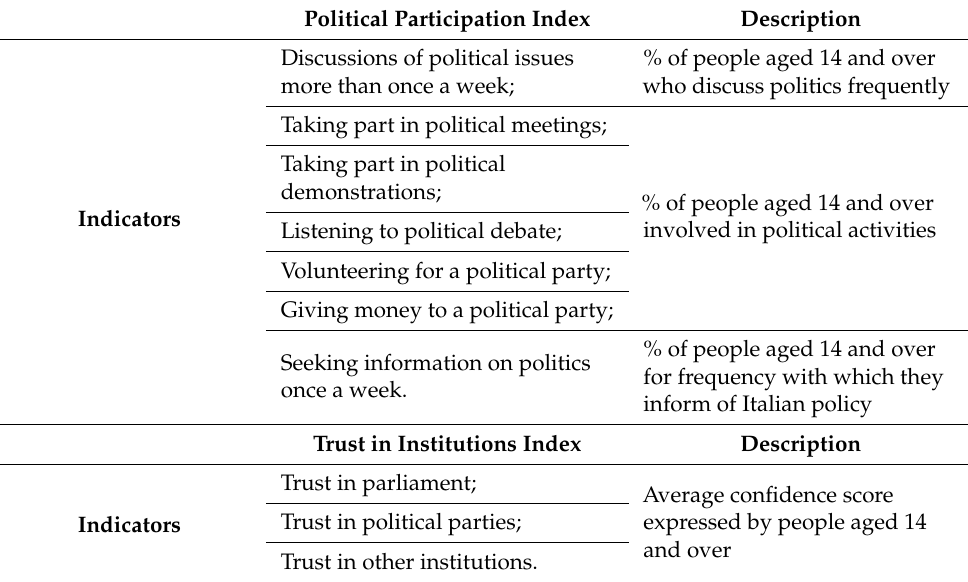
Table 1. Indicators used for the constructions of Political Participation Index and Trust in Institu- tions